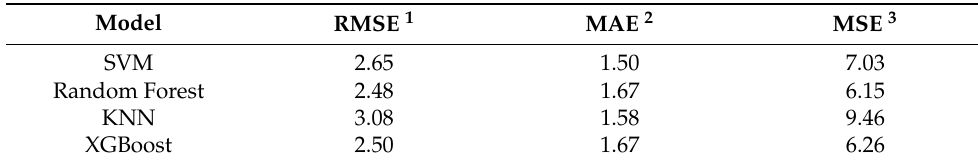
Table 2. Performance of the machine learning models in predicting LOS.